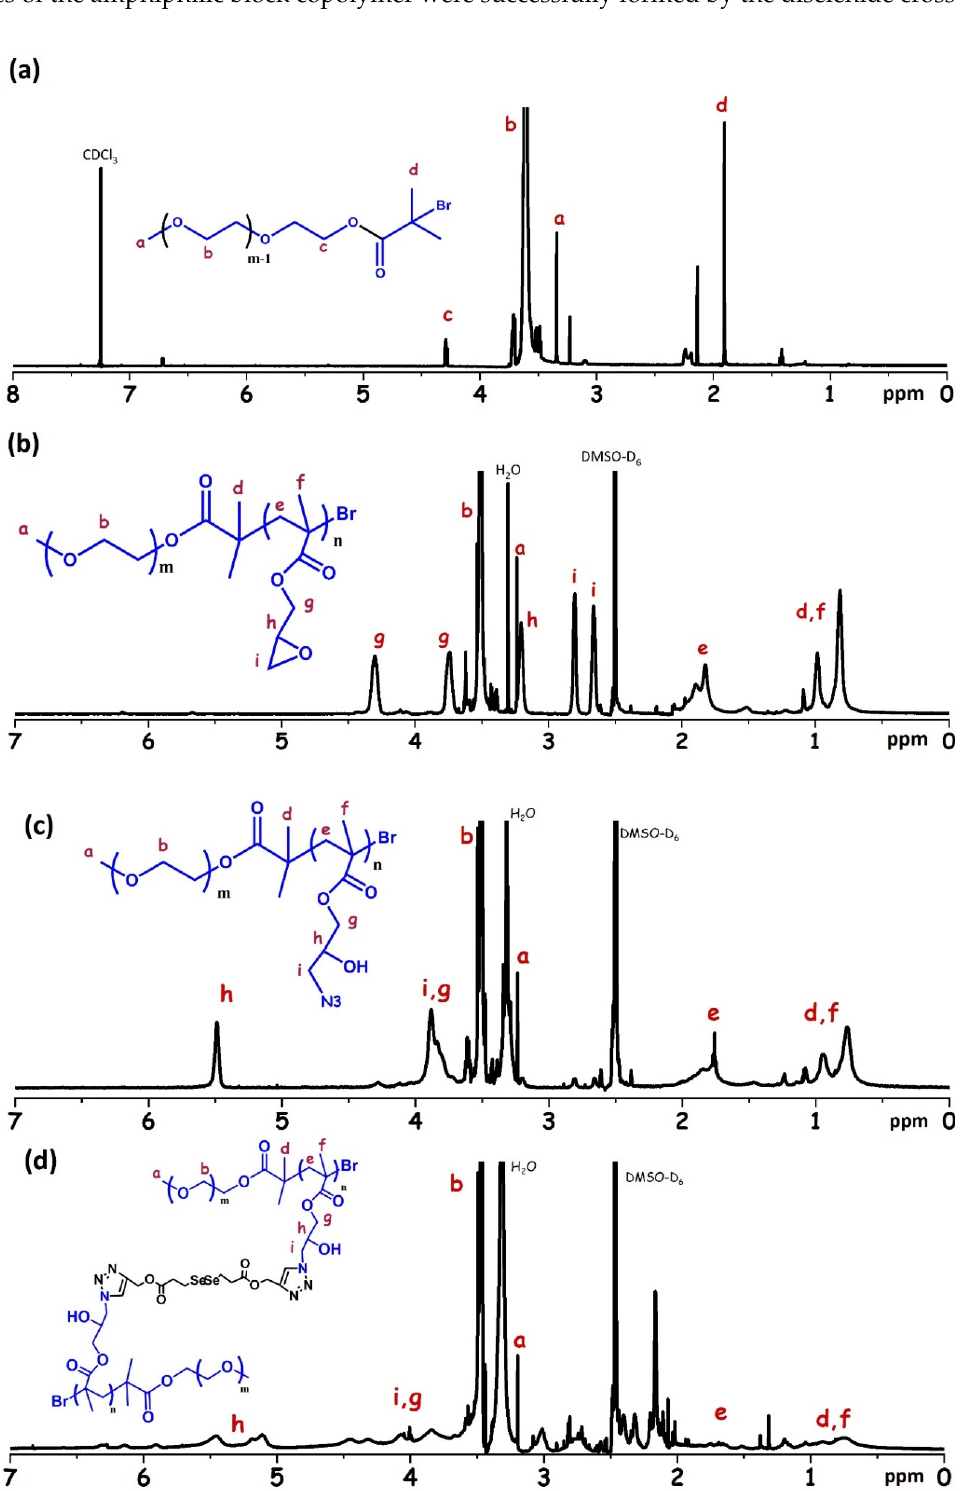
Figure4. 1 HNMRof( a )PEO-Brmacroinitiator, ( b )PEO- b -PGMAblockcopolymer, ( c )PEO- b -PGMA-N 3 , and ( d ) diselenide CCL micelle of PEO- b